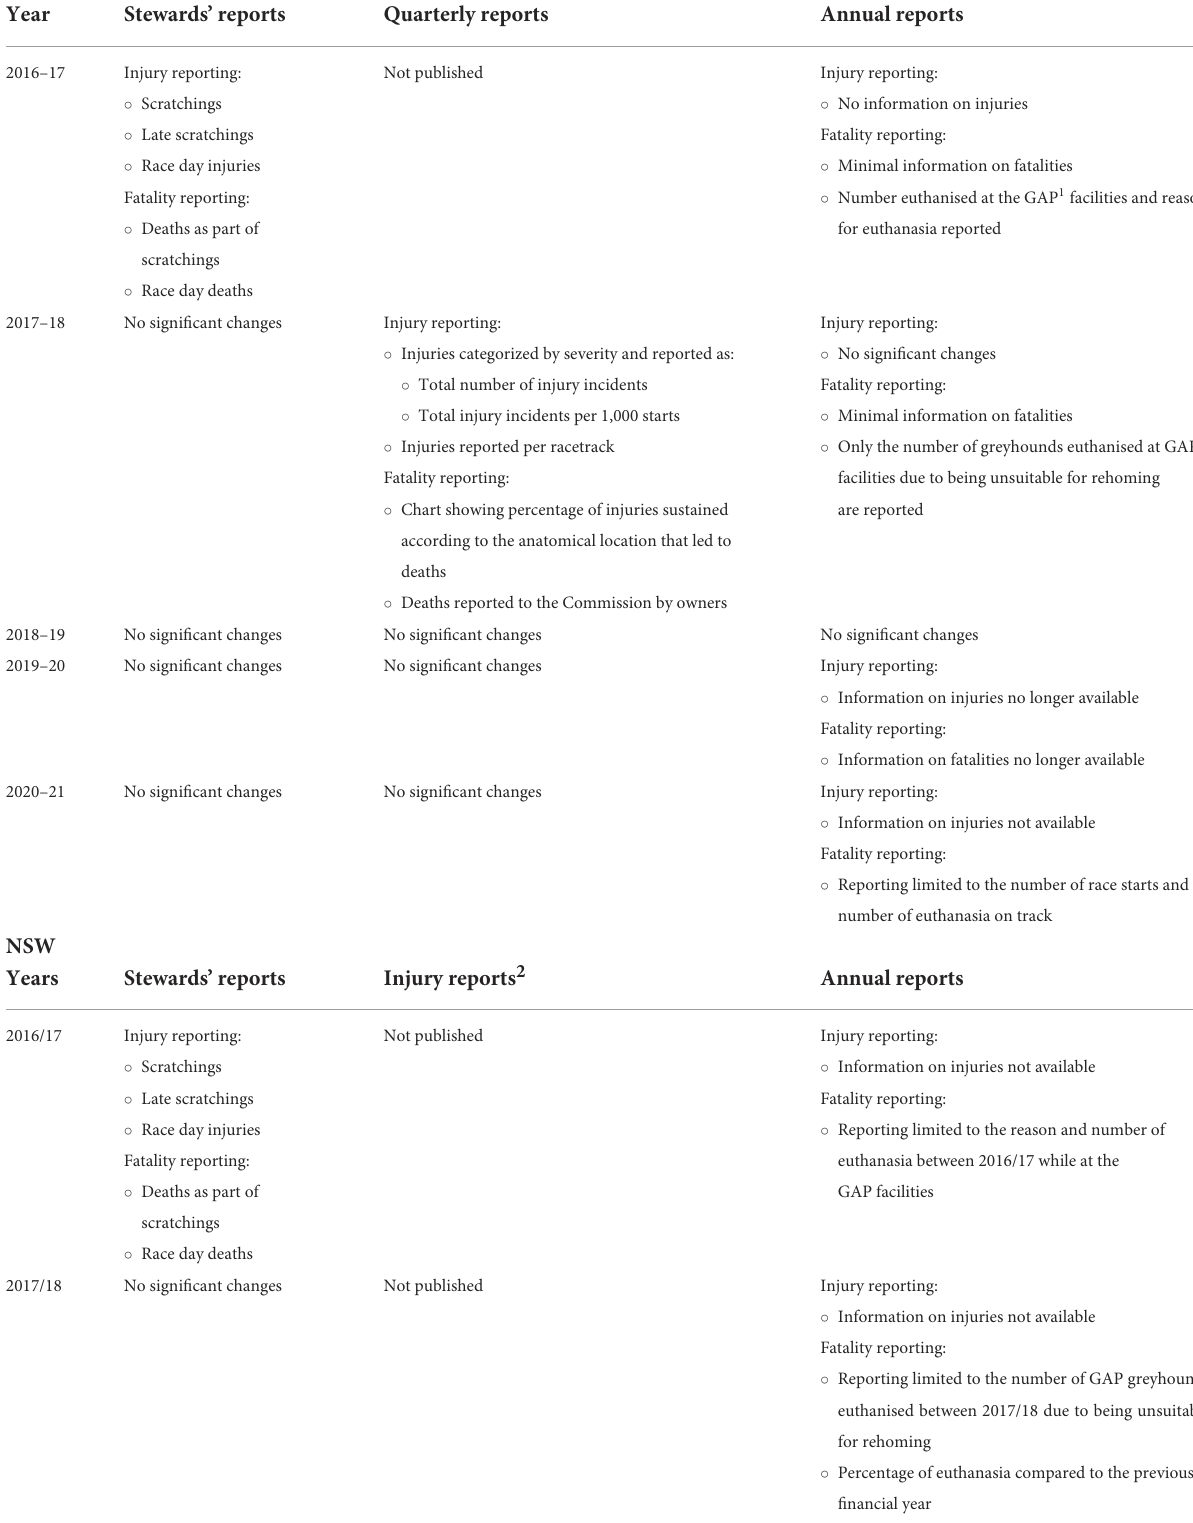
TABLE 2 Summary of changes made to QLD, NSW and VIC stewards’, quarterly, and annual reports published between 2016 and